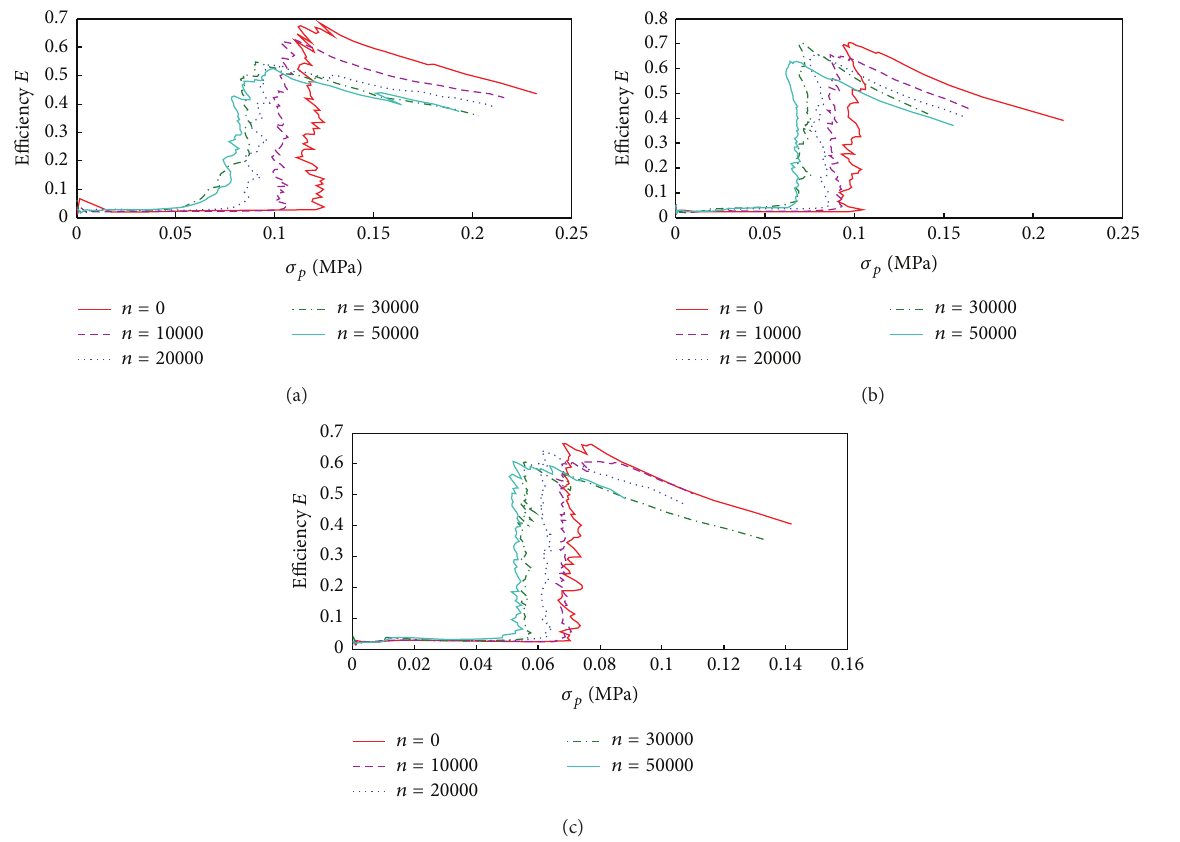
Figure 3: Energy absorption efficiency curves of honeycomb paperboards with different 𝑡/𝑙 value in various FD (23 ∘ C). (a) 𝑡/𝑙 = 0.0263 ; (b) 𝑡/𝑙 = 0.0238 ; (c) 𝑡/𝑙 = 0.0219 . Table 5: Energy absorption per unit volume of paper honeycomb under various FD (23 ∘ C). Thickness-to-length